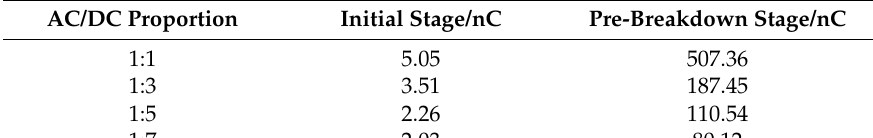
Table 5. Relationship between total discharge amplitude and AC/DC proportions.